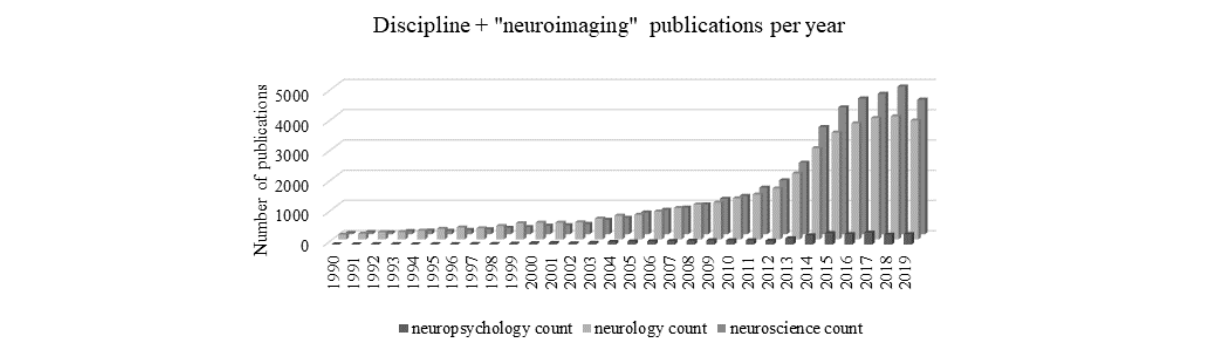
Figure 4. Proliferation of publications identified in the PubMed database over time. Search terms: “neuroimaging” by discipline (eg, “neuropsychology,” “neurology,”